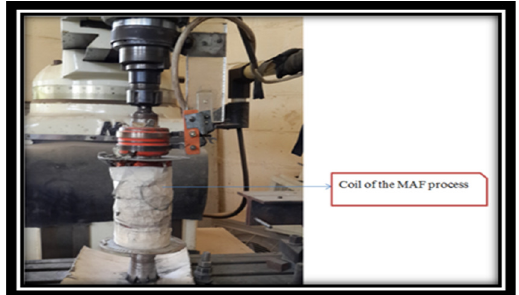
Fig. 1. The coil in the MAF process.